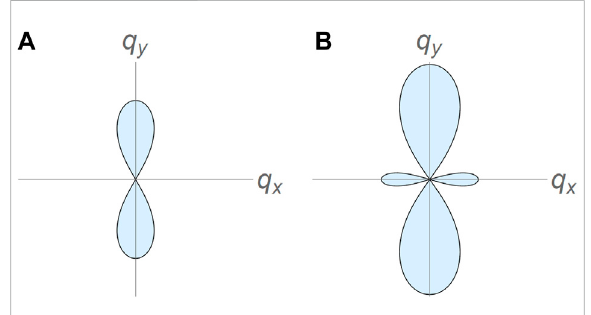
FIGURE 8 Theshadedregioninthe q x - q y planecorrespondstounstable modes( ] > 0)inanextensileactive fl uid.Beyondthecriticalactivity α b q x = 0) become unstable. Further c only the bend modes ( increasing the activity beyond α s c , pure splay modes ( q y = 0) also become unstable. (A) α c b < α 0 < α s c . (B) α 0 > α s c